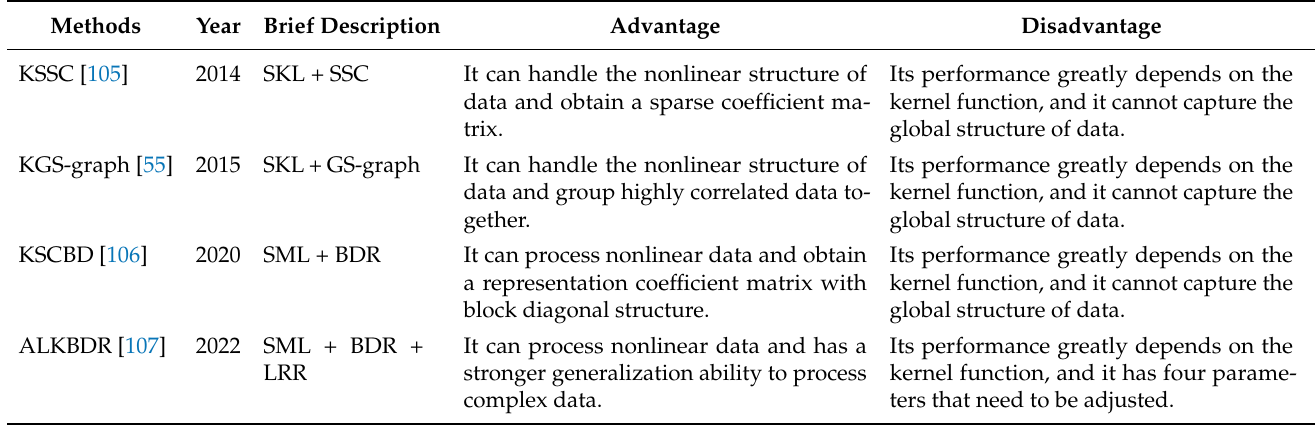
Table 8. The comparison of classical SKL-based SC